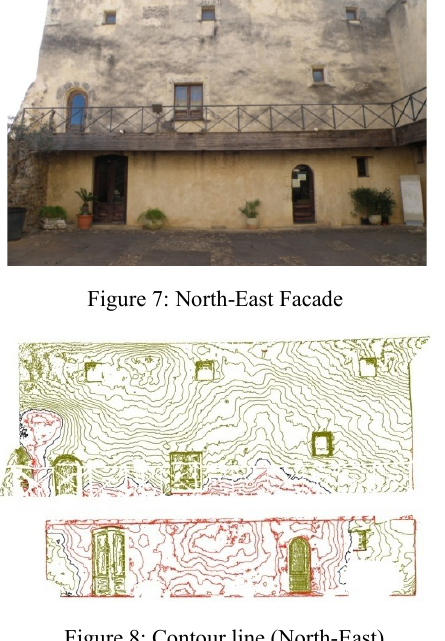
Figure 8: Contour line (North-East)